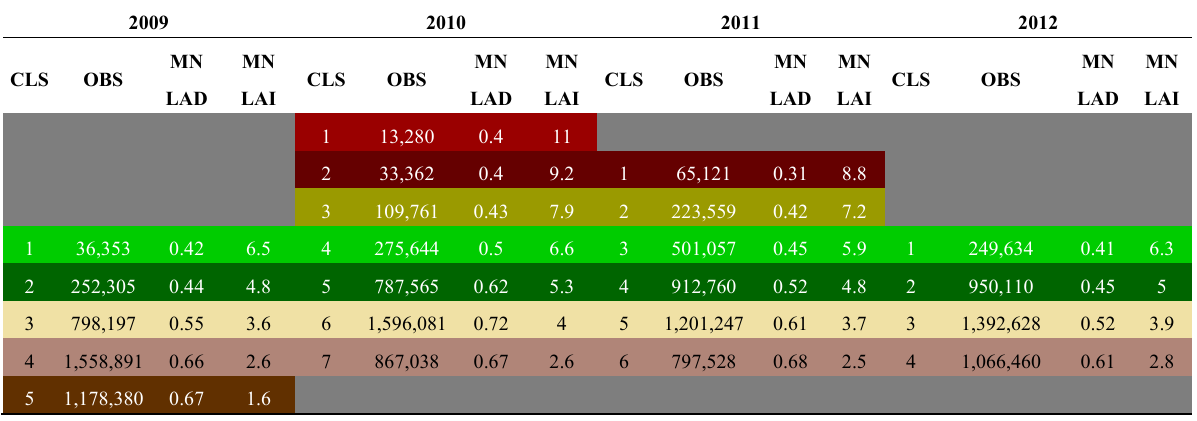
Table 4. Classes are aligned to best match similar LAI and LAD class means from year to year (Figure 5). Grey shading signifies a comparable class was not found in one year that existed in another year. The same color in each year signifies a similar LAI and often a similar LAD. The class colors assigned in the table match the class colors applied in Figure 5. CLS = Class, OBS = the observations (or pixels) comprising each class and MN =